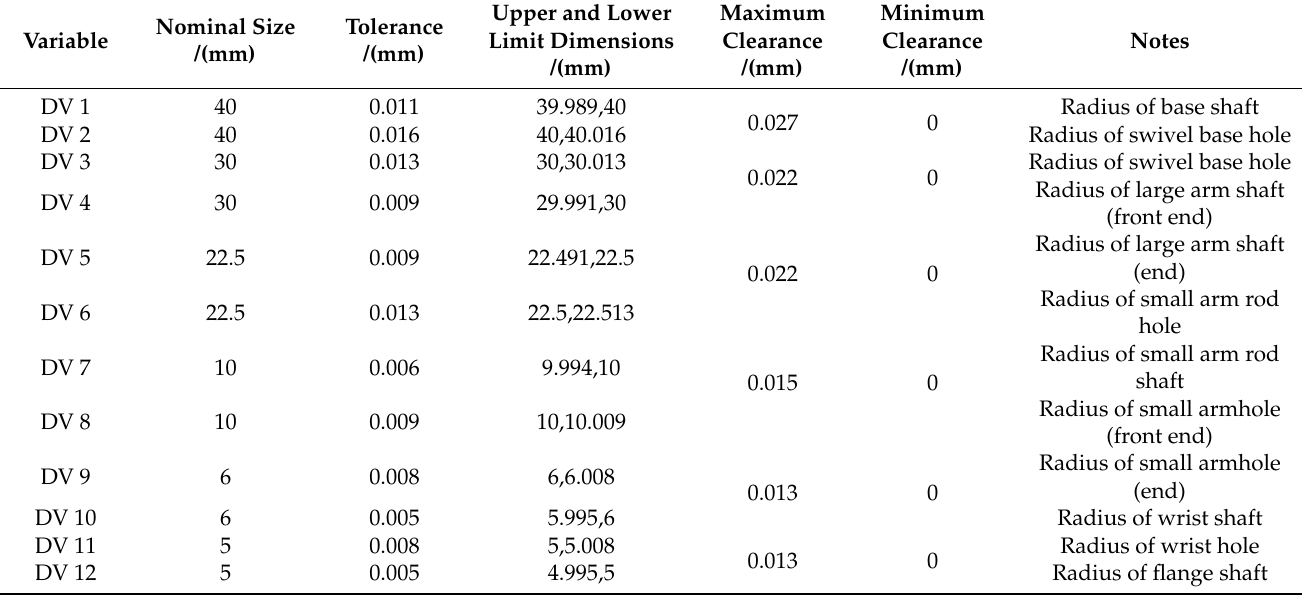
Table 2. Table of values of design variables for shafts and holes at joints.